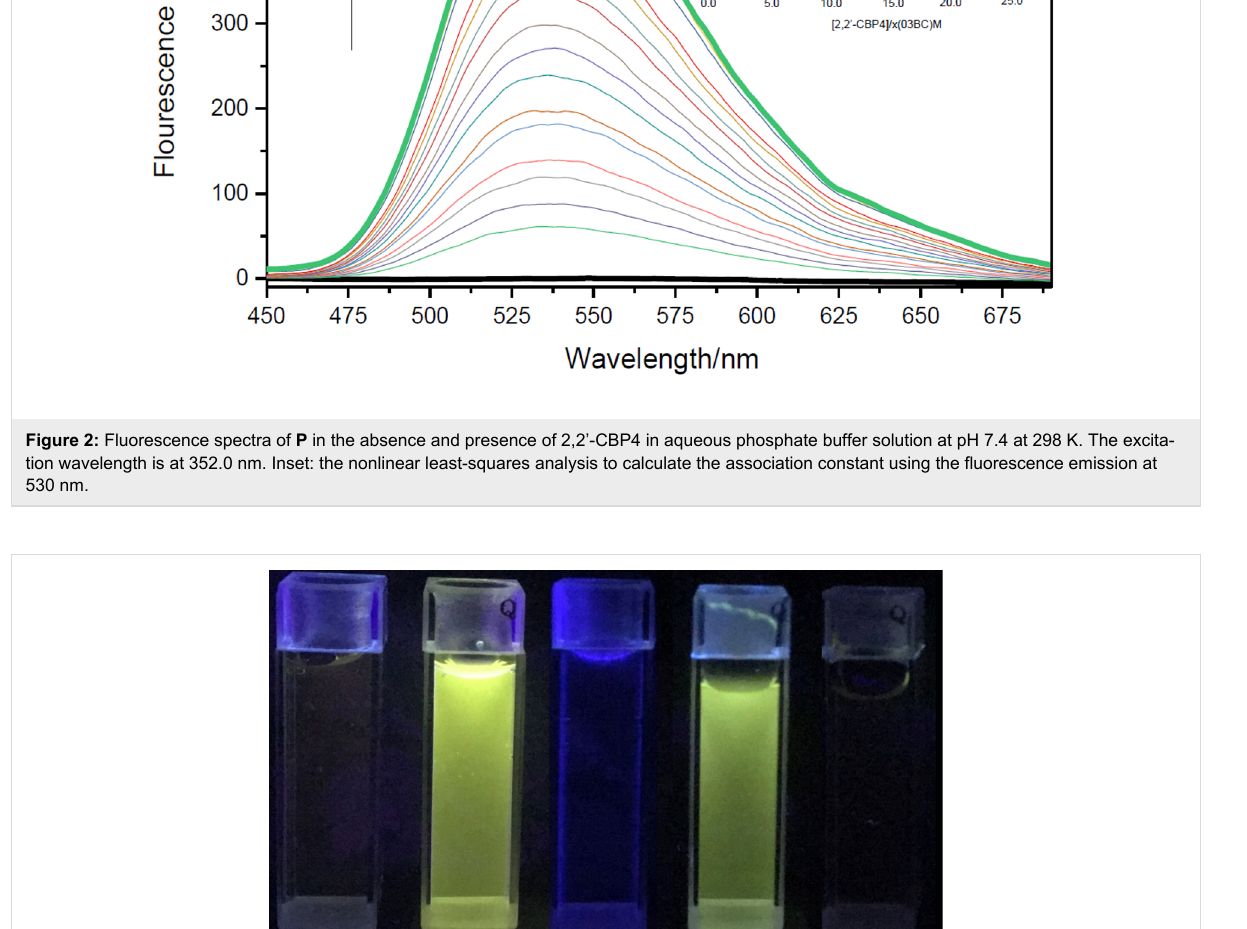
termined to be 1:1 by Job plot analysis (Supporting Information File 1, Figures S13 and S14). The nonlinear least-squares curve- fitting method was used to analysis. For each host–guest